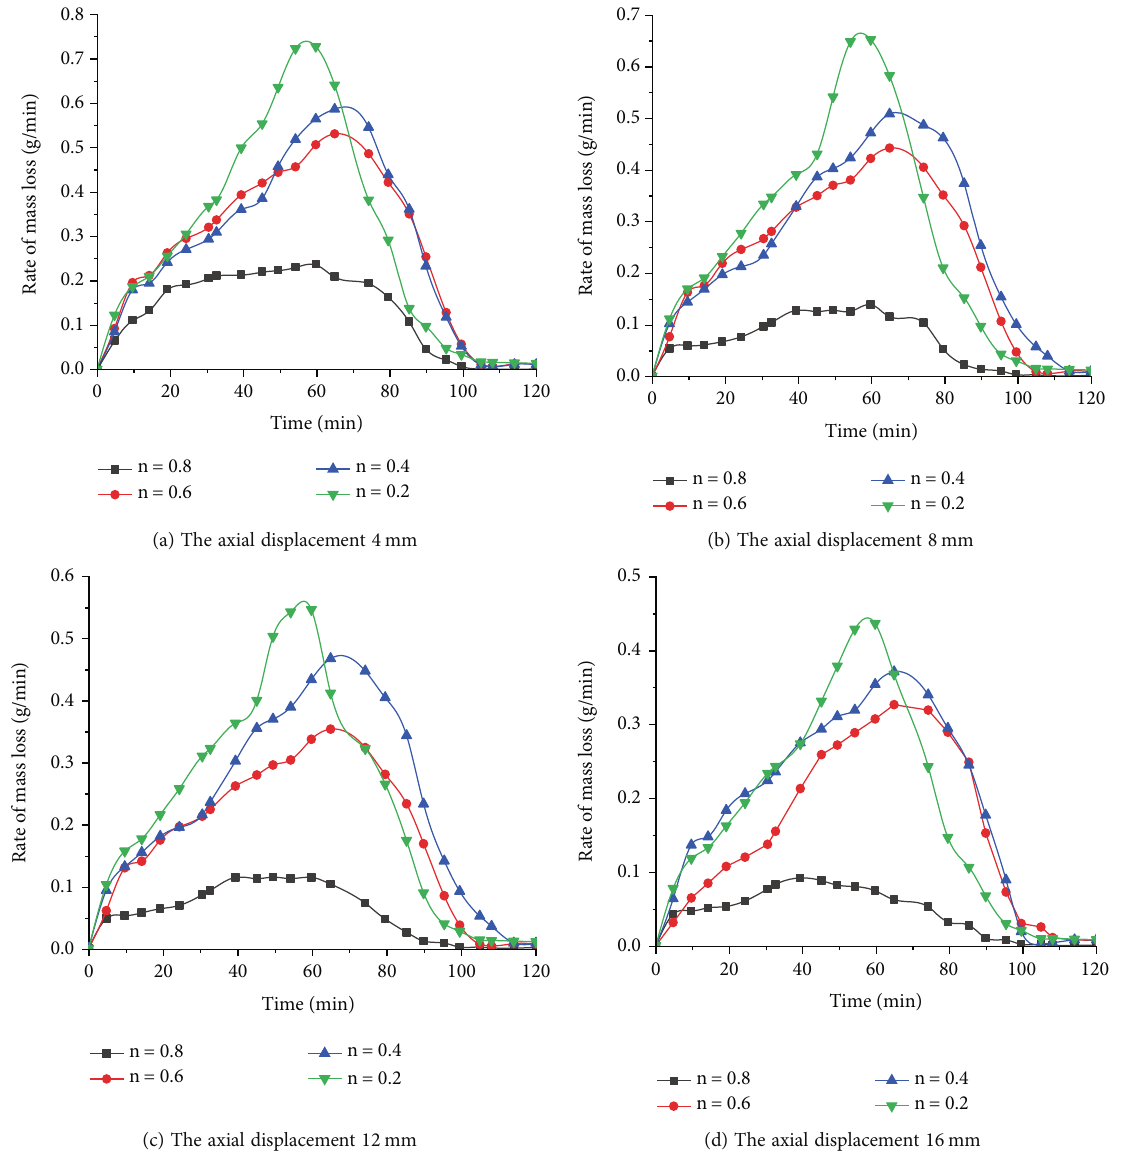
Figure 4: Evolution curve of mass rate of lost grains under di ff erent axial